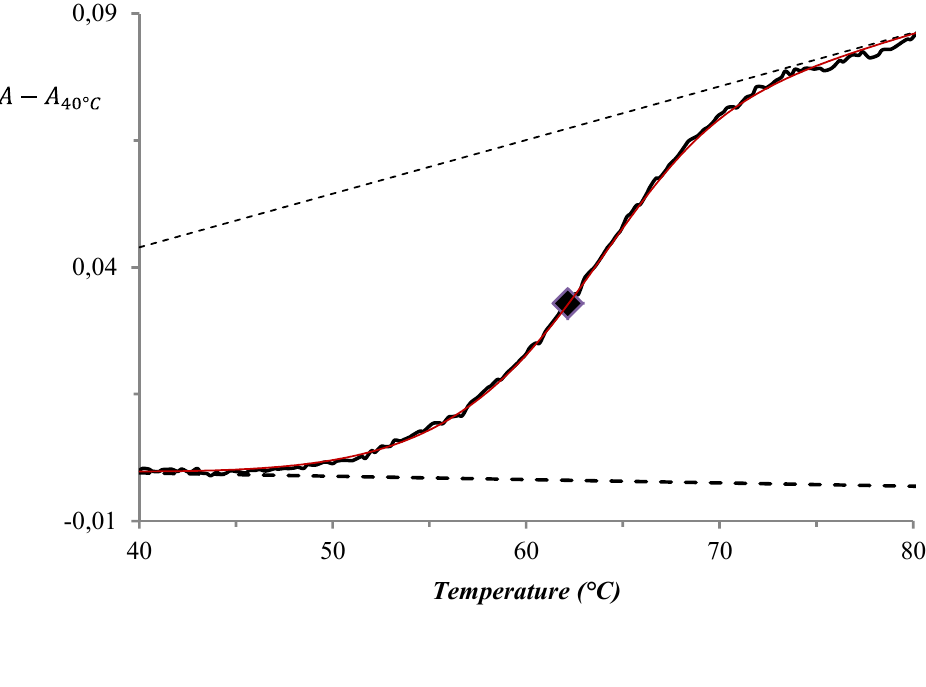
Figure A3. Thermal denaturation curve of the DNAA11-DNAT11 duplex (5 µM) followed by UV-Vis absorption spectroscopy at 260 nm in a 10 mM phosphate buffer containing 500 mM NaCl at pH =